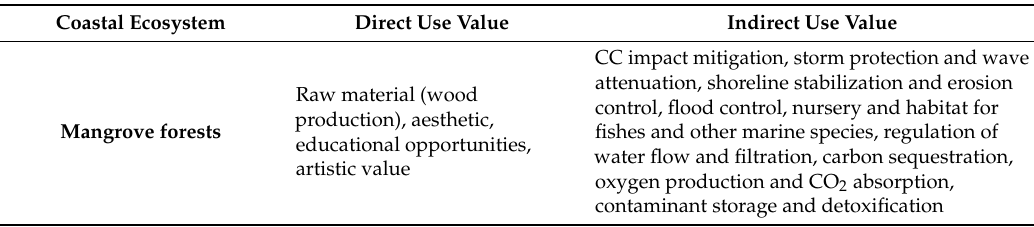
Table 2. Overview of coastal ecosystems and their attributed use-value